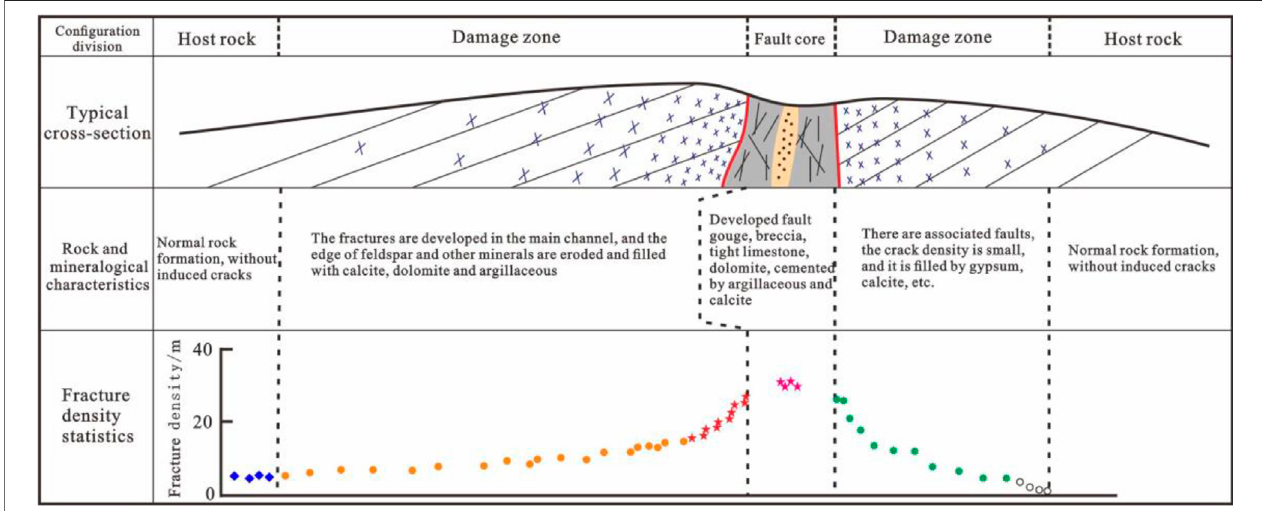
FIGURE 10 | The reservoir development rule is controlled by fracture of Xike ’ er reverse fault zone. The typical Xike ’ er pro fi le shows that fractures are generally not developedinthehostrock.Thedamagezoneisseriouslydamaged,andalargenumberoffracturesaredeveloped,andcalcitecementationanddissolutioncoexist.The shape of fault core changes greatly, and fault gouge, fault breccia and calcite cement are mainly developed.